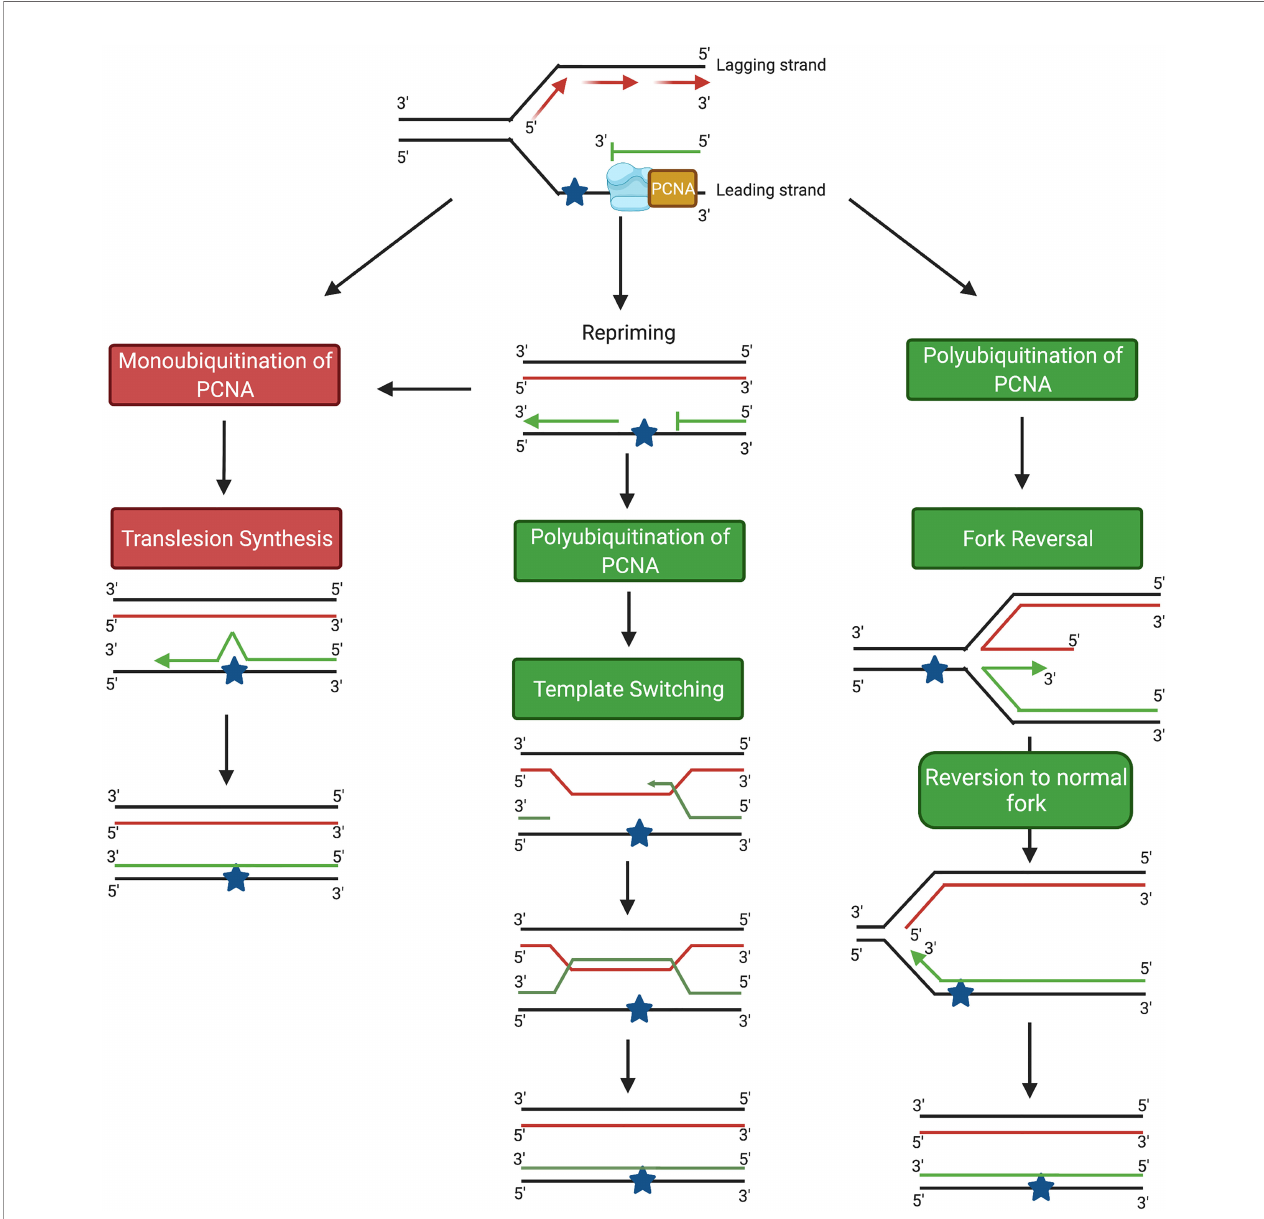
FIGURE 1 | Schematic diagram showing the main DDT pathways in eukaryotic cells. TLS pathways are highlighted in red; homology-based damage tolerance pathways are highlighted in green. Image generated with